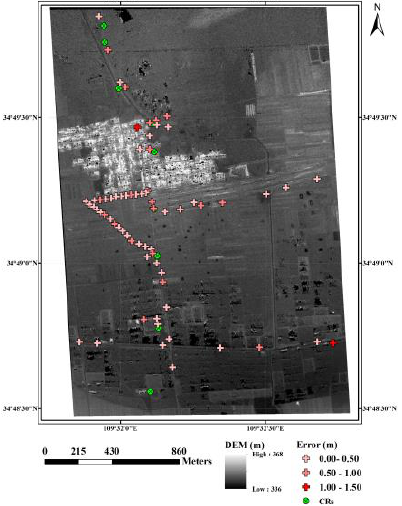
Figure 5. The elevation errors of 70 CPs superimposed on DEM